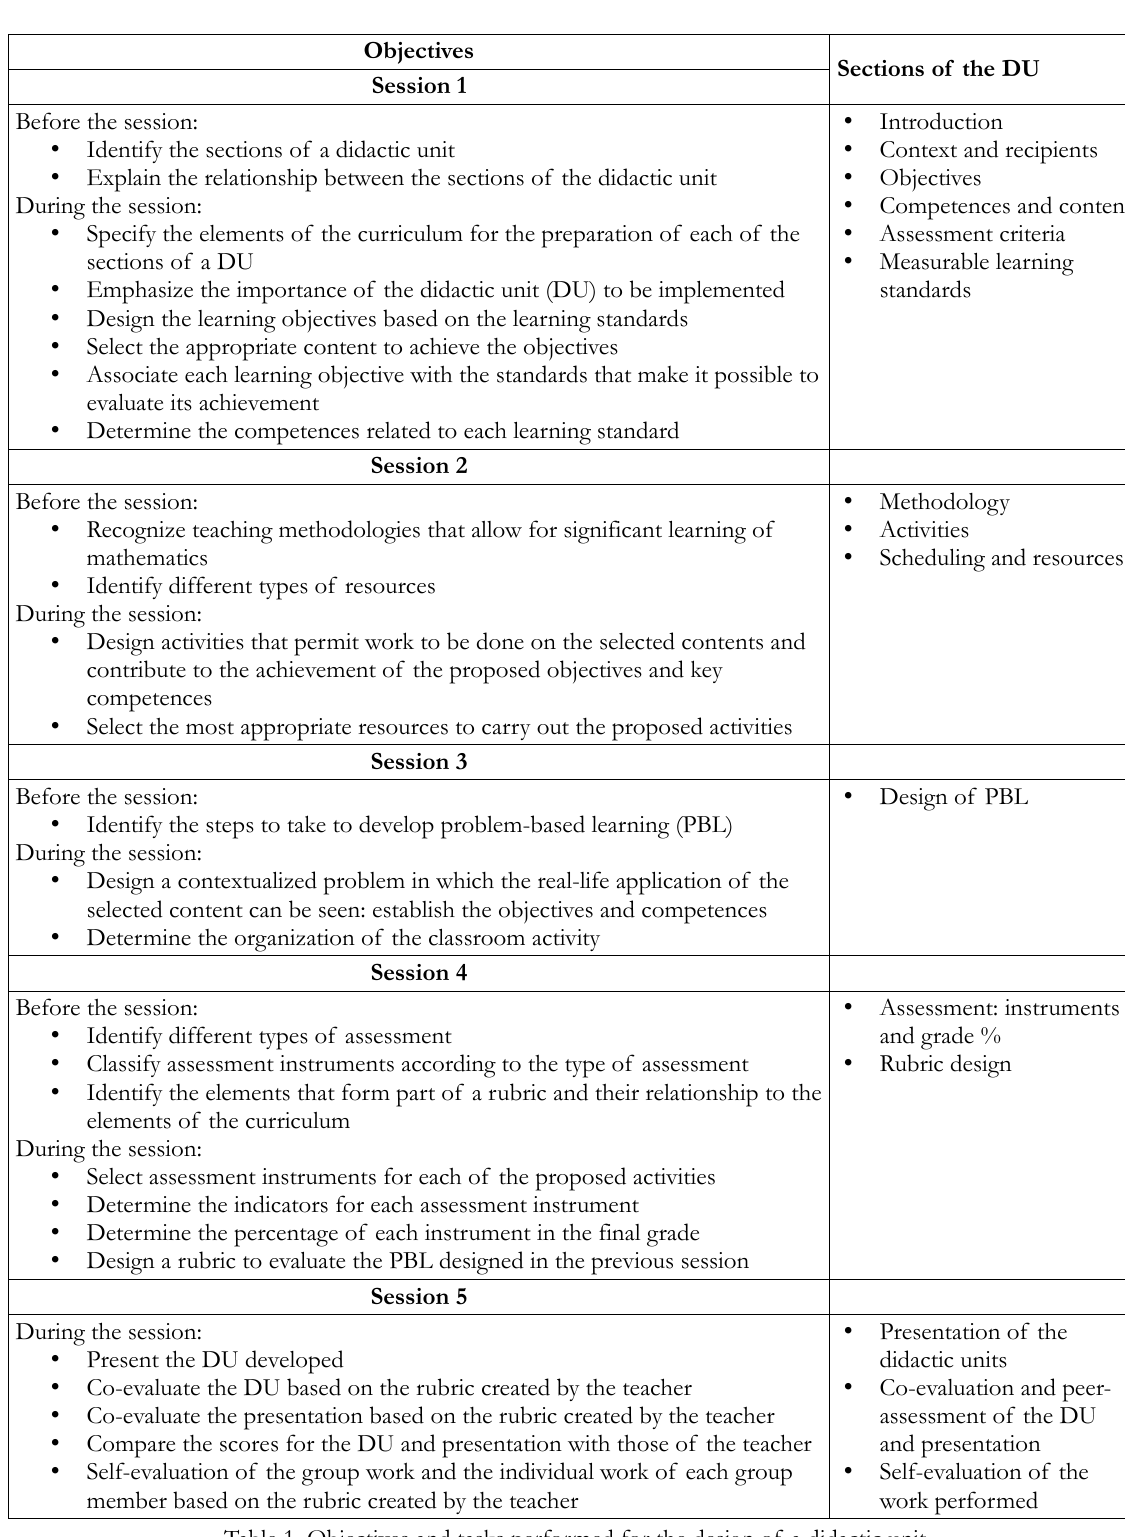
Table 1. Objectives and tasks performed for the design of a didactic